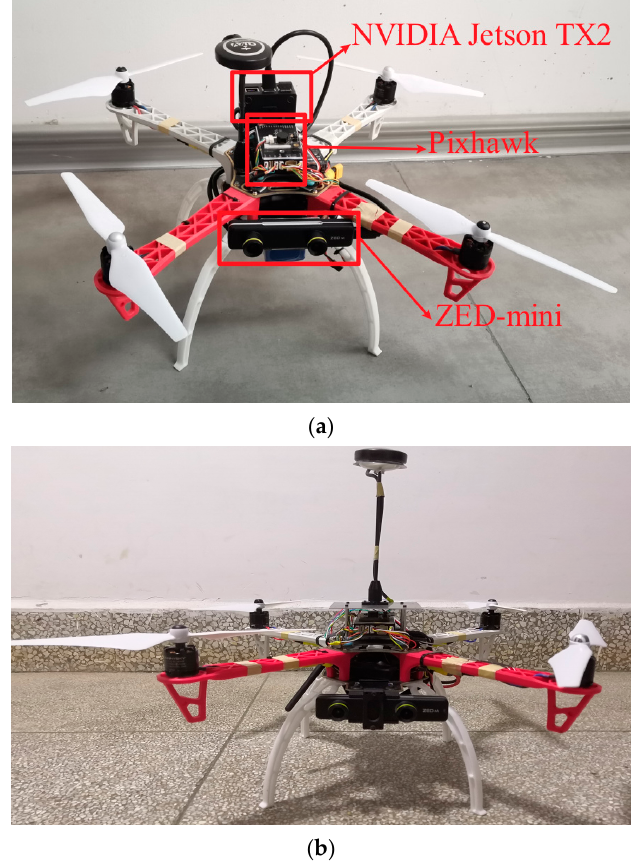
Figure 8 Unmanned aerial vehicle (UAV) platform. ( a ) Top view, ( b ) Front view. Figure 8. Unmanned aerial vehicle (UAV) platform. ( a ) Top view, ( b ) Front